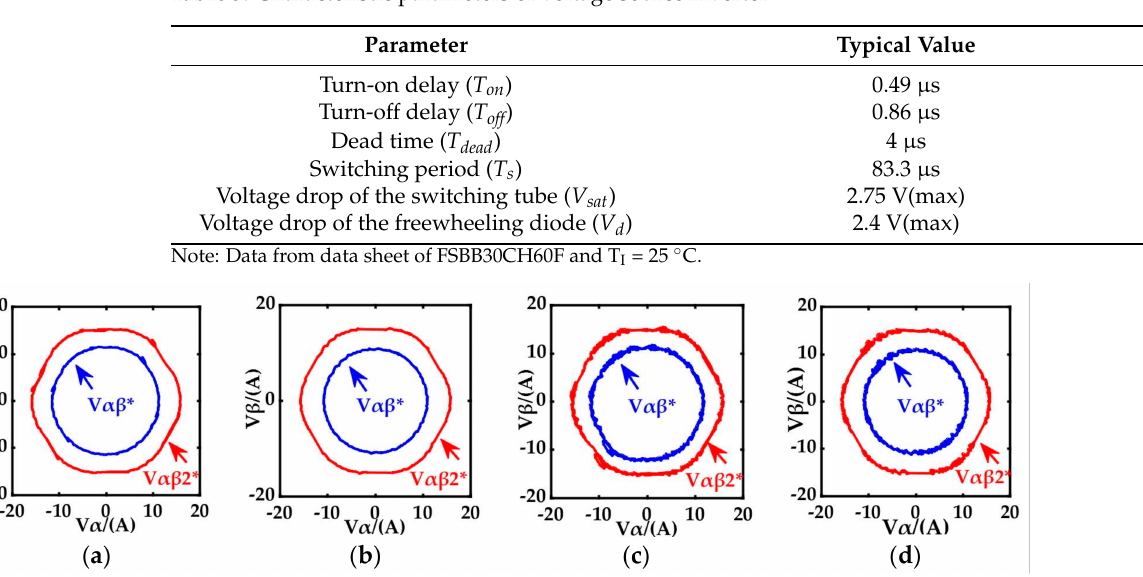
Table 3. Characteristic parameters of voltage source inverter.